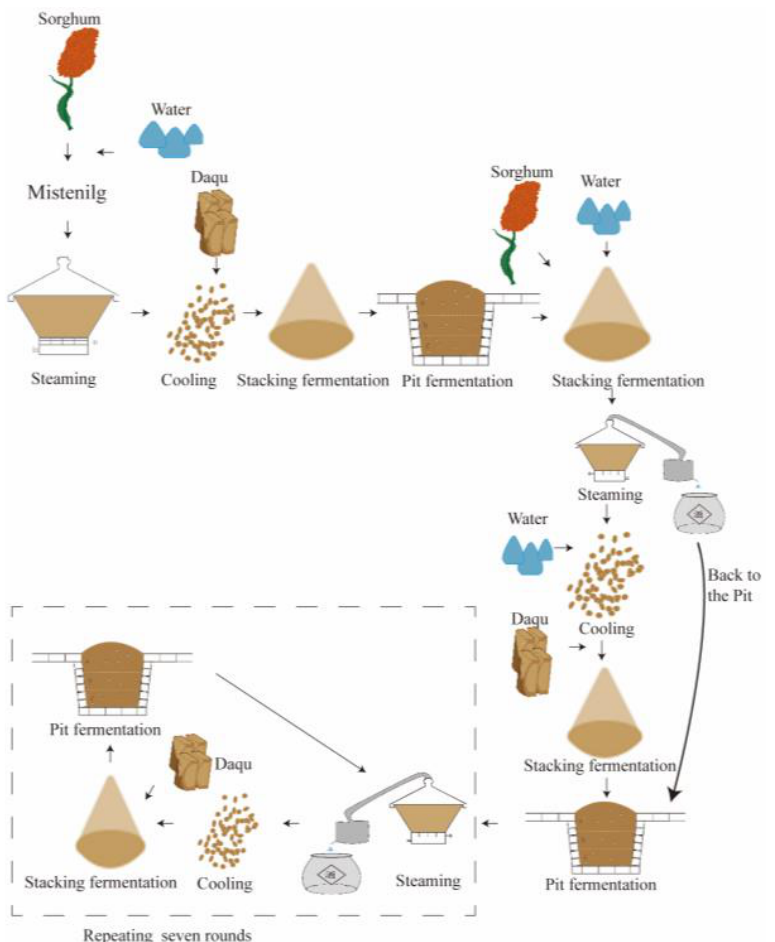
Figure 1. The process of Jiang-flavor Baijiu. The production period of JFB is one year. Firstly, sorghum is used as raw material to go through moistening and steaming, next high temperature Daqu (made of wheat, fermented, and stored) is used as starter, stirred and mixed well, then it undergoes 4–5 days of stacking fermentation and 30 days of pit fermentation, and finally the first round of baijiu is obtained through high temperature distillation. After steaming, distilled grains are mixed with Daqu, and the process of stacking fermentation and pit fermentation are repeated, resulting in a total of seven rounds of base